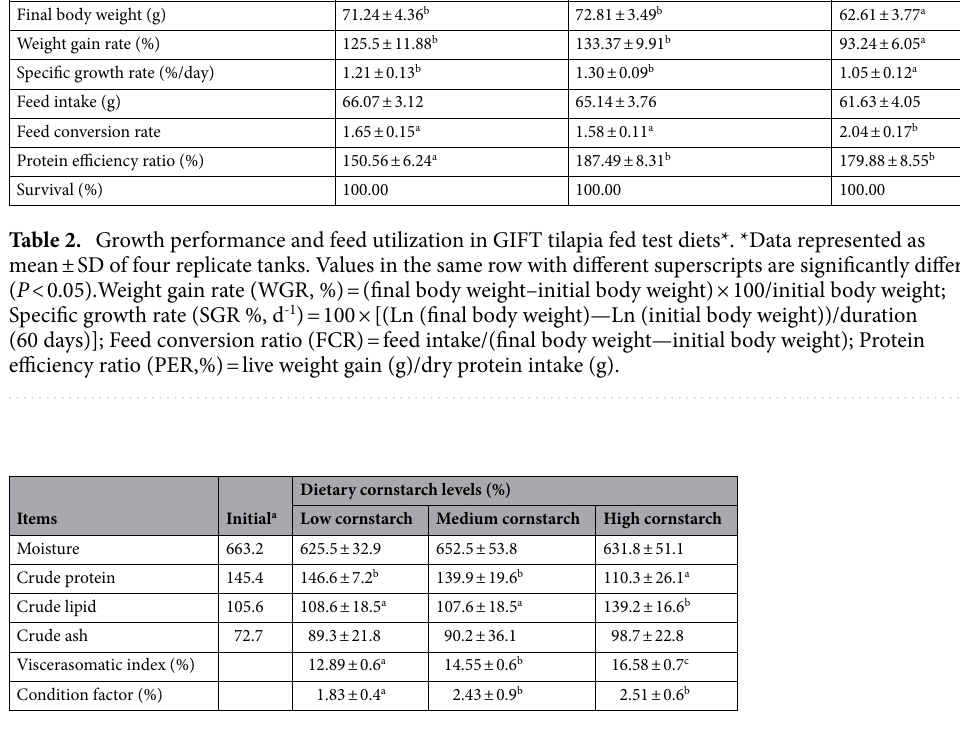
Table 3. Whole body proximate analysis (g/kg wet basis) and somatic parameters in GIFT tilapia fed test diets*. *Data represented as mean ± SD of four replicate tanks. Values in the same row with different superscripts are significantly different ( P < 0.05). a Initial values are not included in the statistical analysis. Viscera index (VSI, %) = 100 × viscera weight/fish weight; Condition factor (CF, %) = 100 × [body weight of fish (g)/length of fish (cm) 3 ].